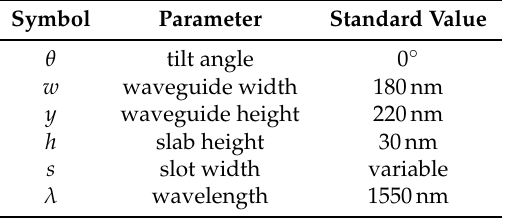
Figure 4. Enlarged section of the slot-waveguide’s design and denotation of its parameters. A large tilt angle θ = 9 ◦ has been used for better visibility. Table 1. Slot-waveguide parameters and their standard